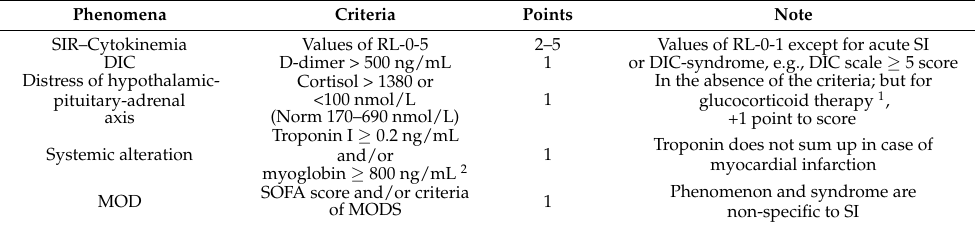
Table 2. Integral SI